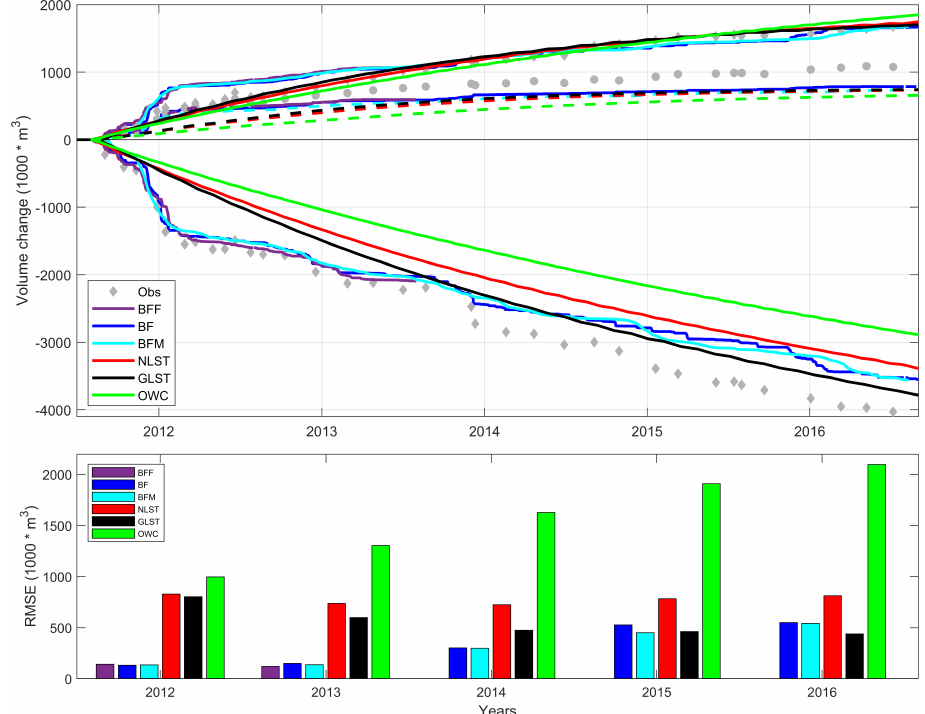
Figure 12. The upper panel presents the volume change in the period 2011–2016 for the three ZM control areas (see Figure 7) for all considered acceleration techniques. The bottom panel presents the RMSEin each year for the four different acceleration techniques and the BF with respect to the observed erosion of the peninsula control areas. Due to long computational times the results of the BFF simulation are presented only for the first two